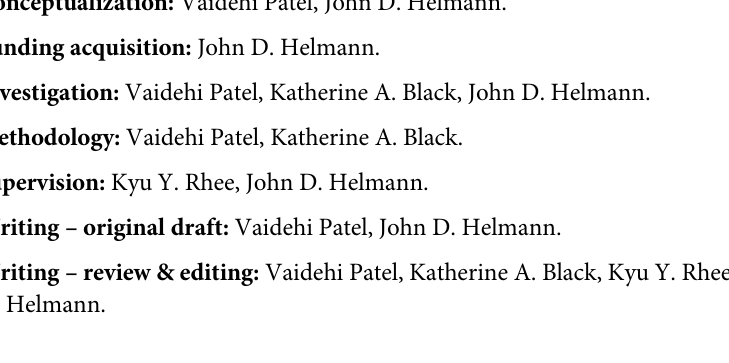
S6 Fig. (A) Images of LB agar plates with 20 mM MgSO plates where WT, pgcA and 4 G47S pgcA G47D were transformed with glmR :: mls . These representative images were taken after over- night incubation at 37 0 C. (B) CEF sensitivity assay was carried out with 6 μ g of antibiotic. 1 mM IPTG was added for induction of pgcA . (C) Images showing SPP1 phage infection G47D assay. Cell lysis was observed after overnight incubation at 37 0 C. 10 μ l of 10 7 PFU/ml SPP1 was spotted on the lawns B . subtilis strains of interest. Shown pictures are representative of at least three biological replicates. S7 Fig. Growth assay on gluconeogenic MH medium carried out with and without 1 mM IPTG. Pictures were taken after overnight incubation of plates at 37 0 C. These images are rep- resentative of at least three biological replicates. S8 Fig. Multiple sequence alignment carried out using Clustal Omega for Trypanosoma brucei phosphoglucosamine mutase with B . subtilis PgcA and GlmM. Residues corre- sponding to B . subtilis G47 are highlighted in blue. S1 Table. Summary of data displayed in S2 Fig. S2 Table. Summary of data displayed in S3 Fig. (TIFF) S3 Table. Primers used in this study.